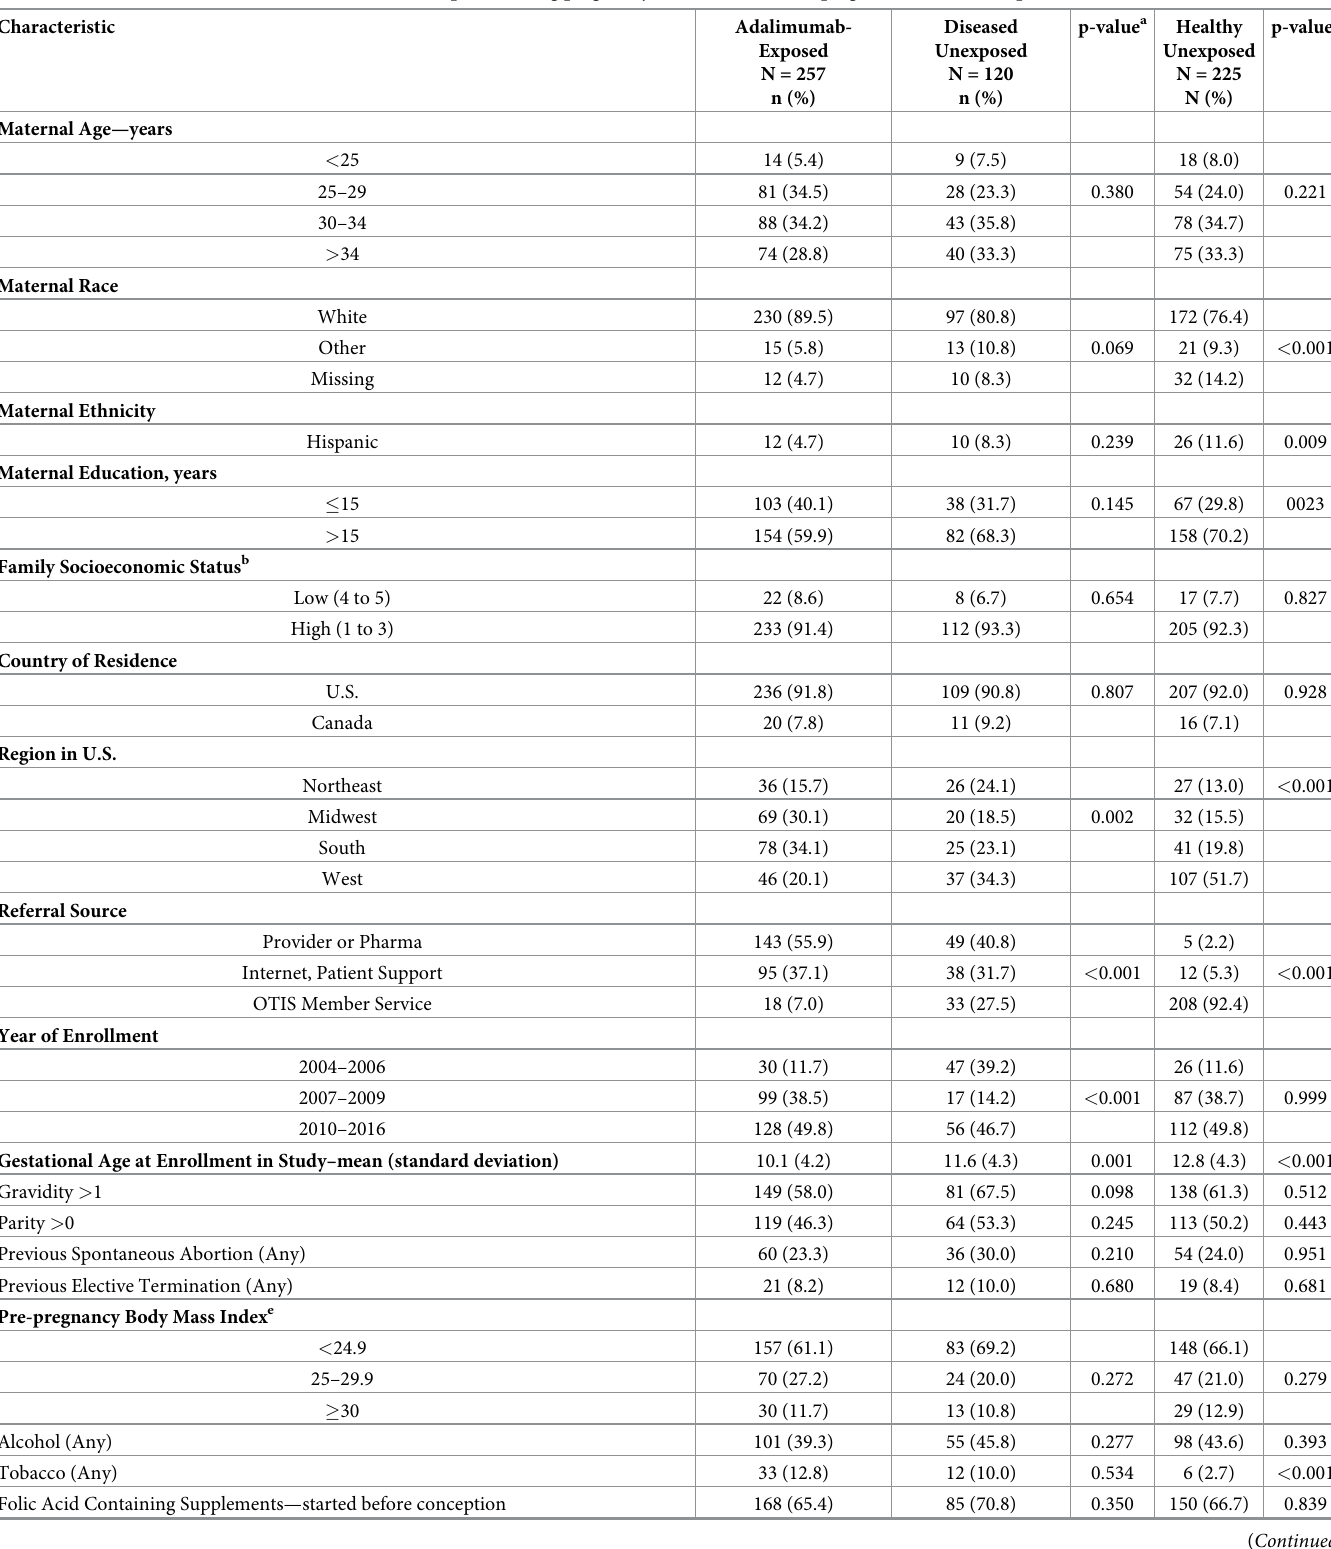
Table 1. Selected maternal characteristics of women exposed during pregnancy to adalimumab and pregnant women not exposed,